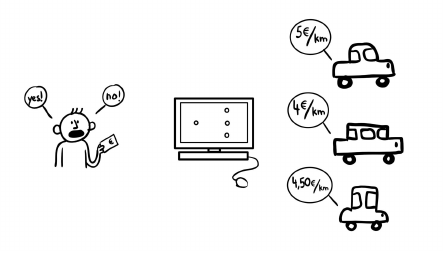
Figure 3. Illustrationof the hybridPP/A mechanisms.In hybrid